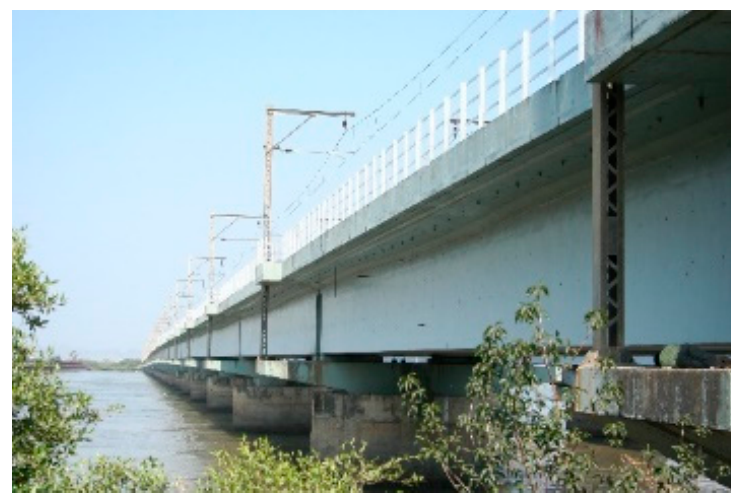
Figure 1. Commercial optical fiber sensor.